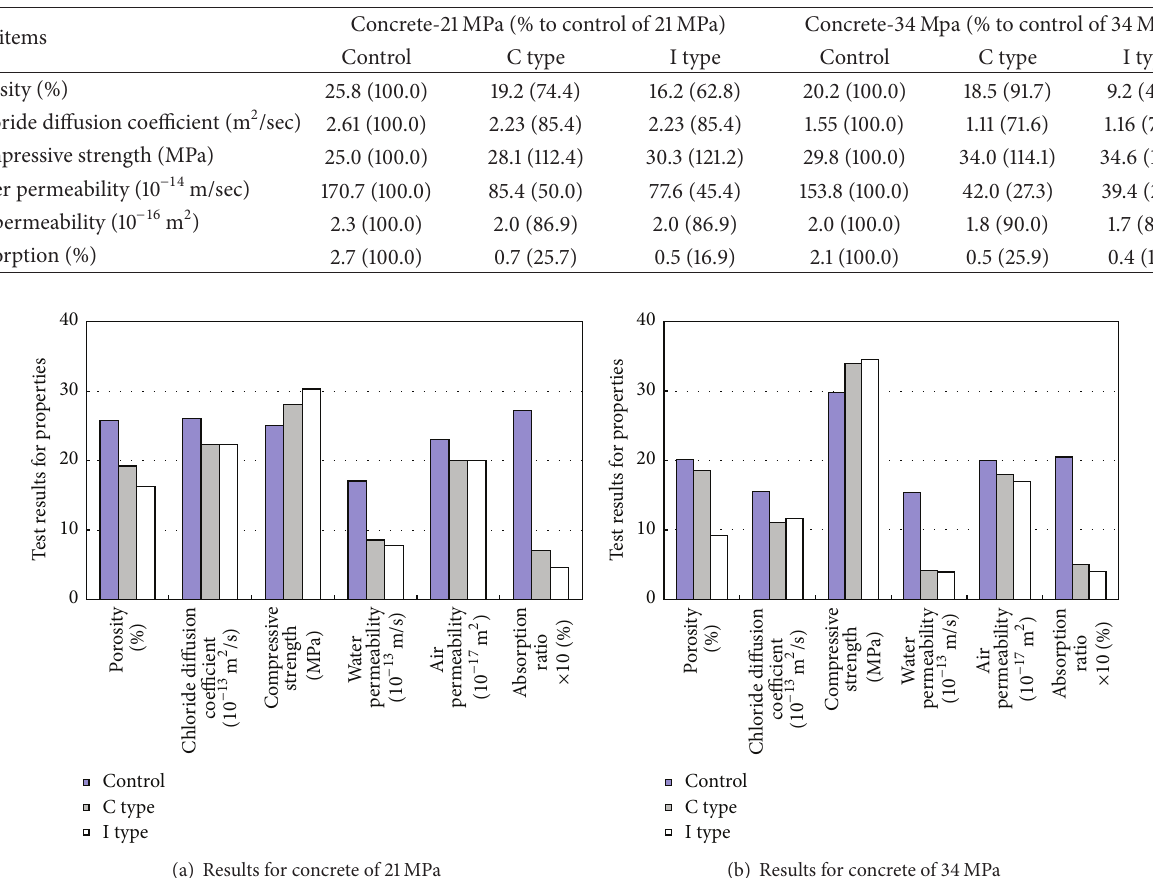
(b) Results for concrete of 34MPa